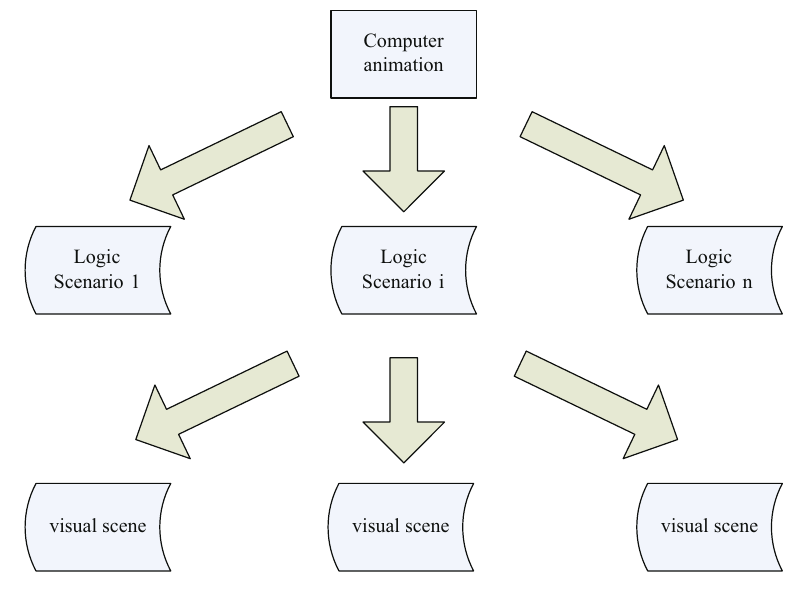
Figure 2: Two - story tower structure for visual